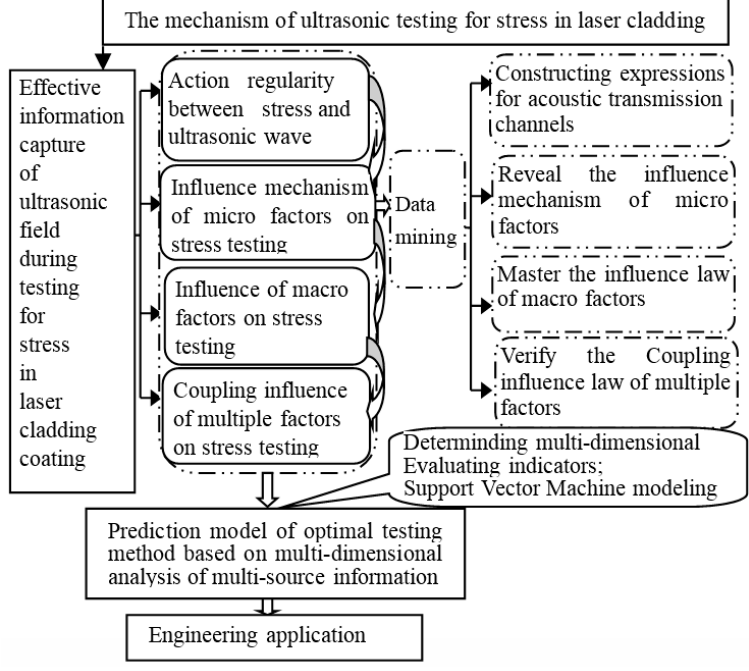
Figure 10. Technology roadmap.